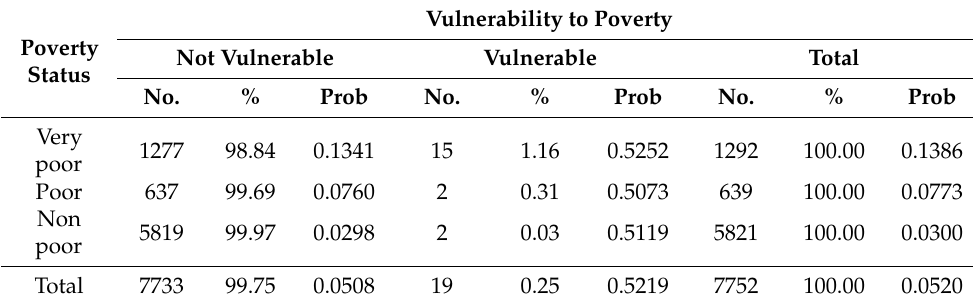
Table 8. Vulnerability with Social Expenditure, 2005/2006.